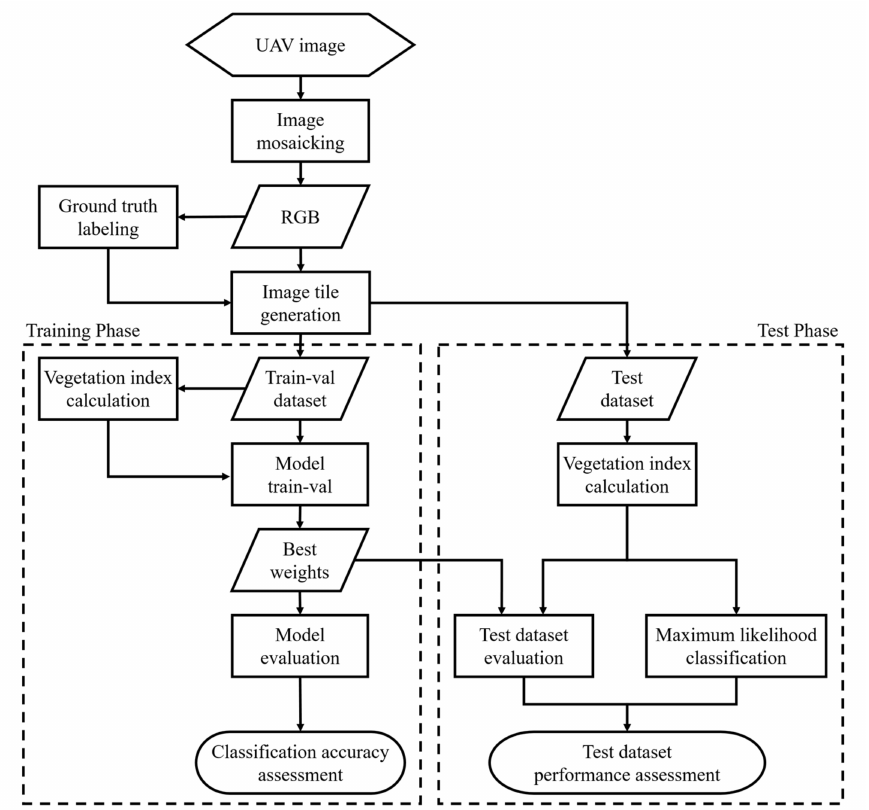
Figure 3. Research